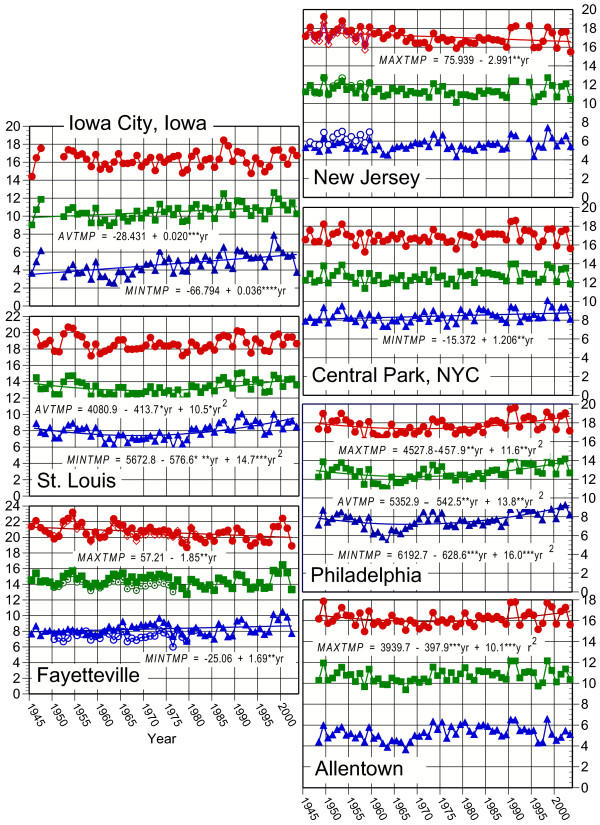
Temperature data for each site in this study plotted from 1945 to 2003. Regression lines and equations are shown only for statistically significant trends in mean maximum monthly temperature (MAXTMP), mean monthly temperature (AVTMP), and mean minimum monthly temperature (MINTMP) at each site. Significance and sign of the regression coefficients are indicated (*P < 0.05, ** P < 0.01, *** P < 0.001, **** P < 0.0001). Y axes are in degrees Centigrade. Replicate data plotted for Fayetteville and New Jersey show incomplete secondary weather station data at sites closer to the locations where flies were collected. See text for details.